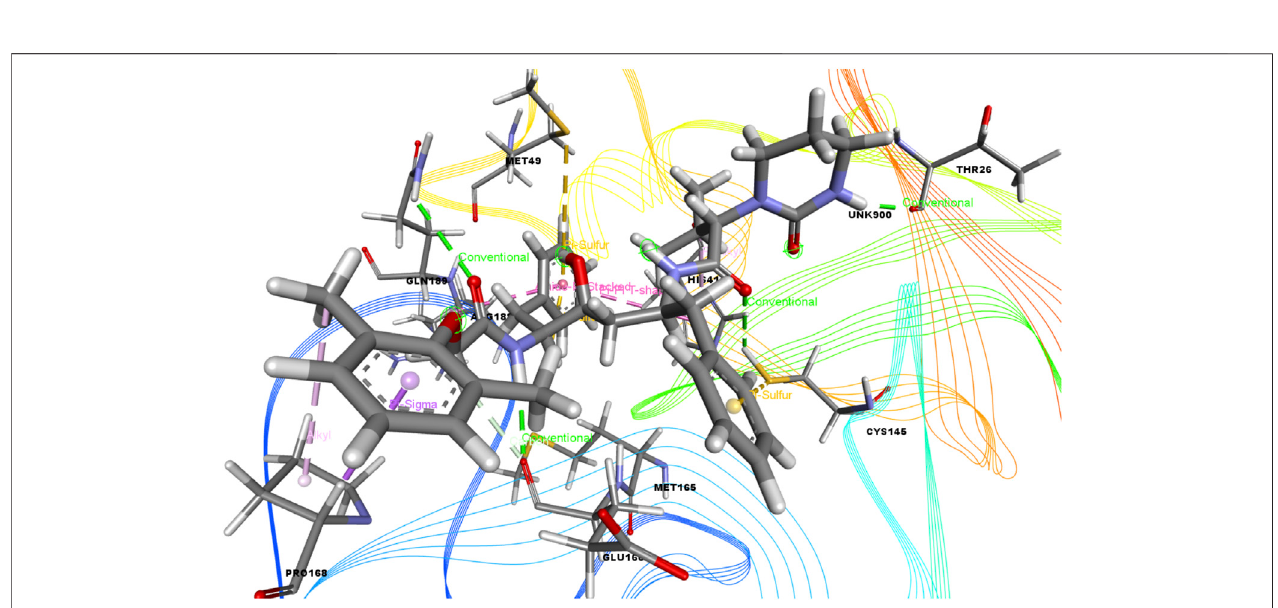
Frontiers in Molecular Biosciences |